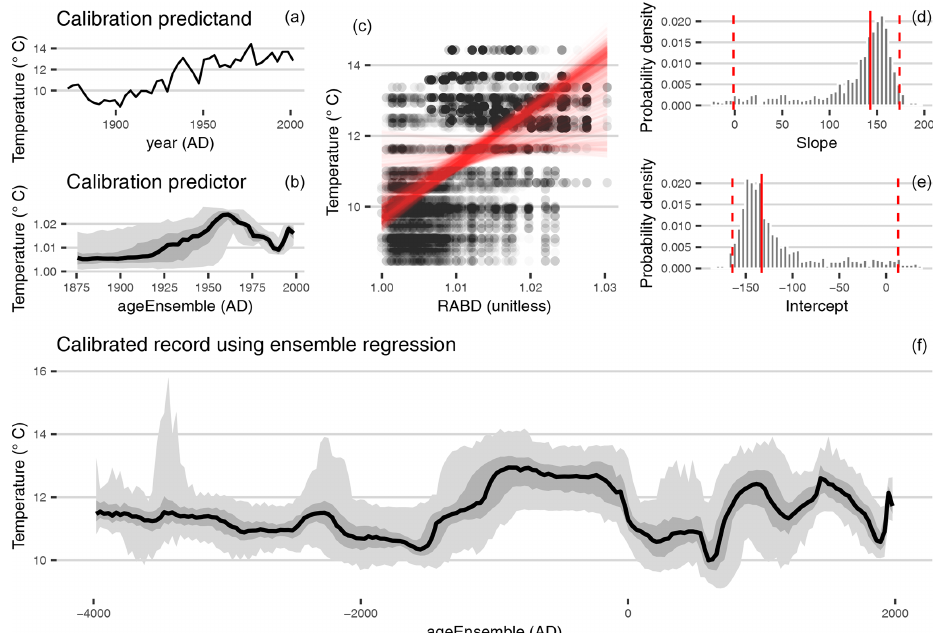
Figure 6. Results of ensemble regression. (a) The calibration-in-time predictor and predictand. The predictand shows the effect of age uncertainty, the median is shown in black, and the 50% and 95% highest-probability density regions are shown in dark and light gray, respectively. (b) Scatterplot showing the relation between RABD and temperature. Points from 100 age ensemble members are plotted with transparency to highlight data overlap. Ensemble regression models are plotted with semi-transparent red lines. (d, e) Distribution of regression model slope (d) and intercepts (e) . Vertical red lines show the 50th (solid), 2.5th and 97.5th (dashed) percentiles. (f) Reconstructed temperature using age ensembles and regression model ensembles. The median estimate is shown in black, and the 50% and 95% highest- probability density regions are shown in dark and light gray,